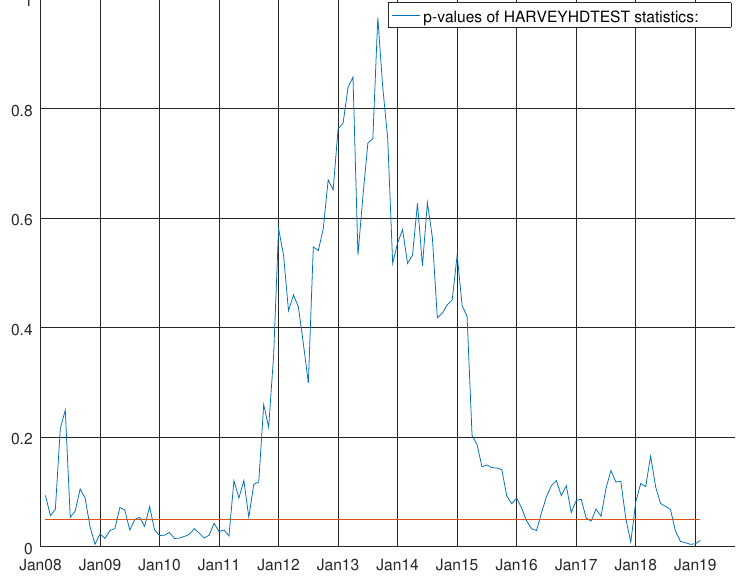
Figure 15. Graph showing the p -values of the Harvey heteroskedasticity test for the enhanced model for intermediate goods. The null hypothesis states that the residuals are not